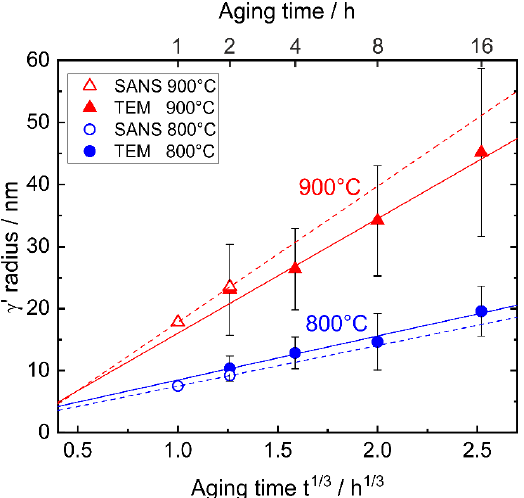
Figure 7. Mean radius of the secondary γ (cid:48) precipitates as a function of the aging time for di ff erent aging temperatures, as determined by SANS and TEM.